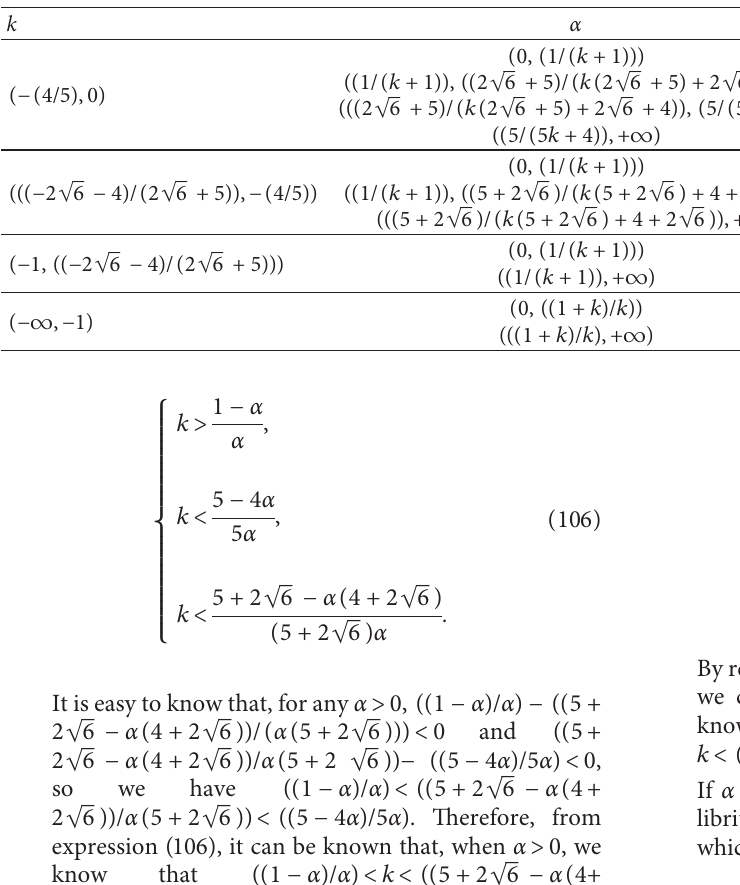
Table 2: Criterion for scenario 1 ( k is fixed, α is control parameter and k <